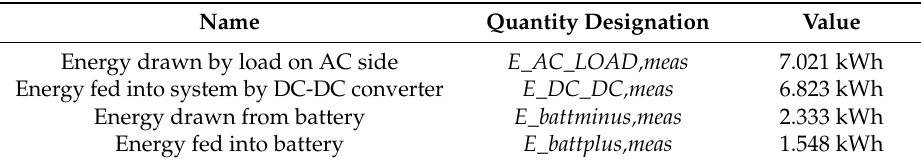
Table 2. Energy comparison during validation—measured values.